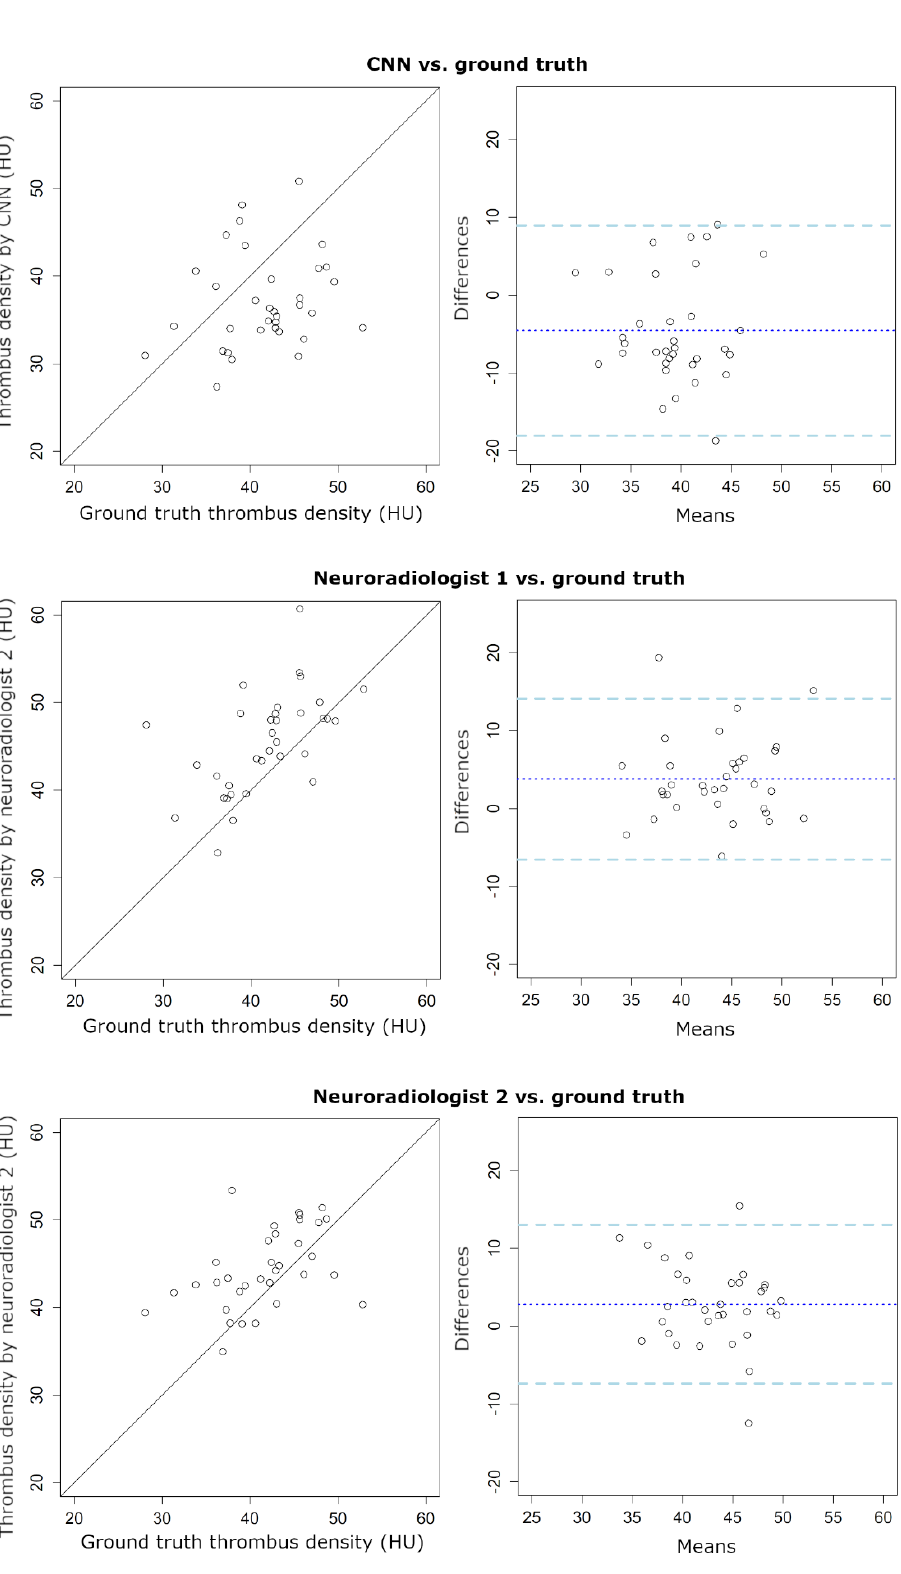
Figure 3. Scatter ( Left ) and Bland – Altman plots ( Right ) for thrombus volumes. The dotted line and dashed lines within the Bland – Altman plot represent the bias and limits of agreements, respectively.